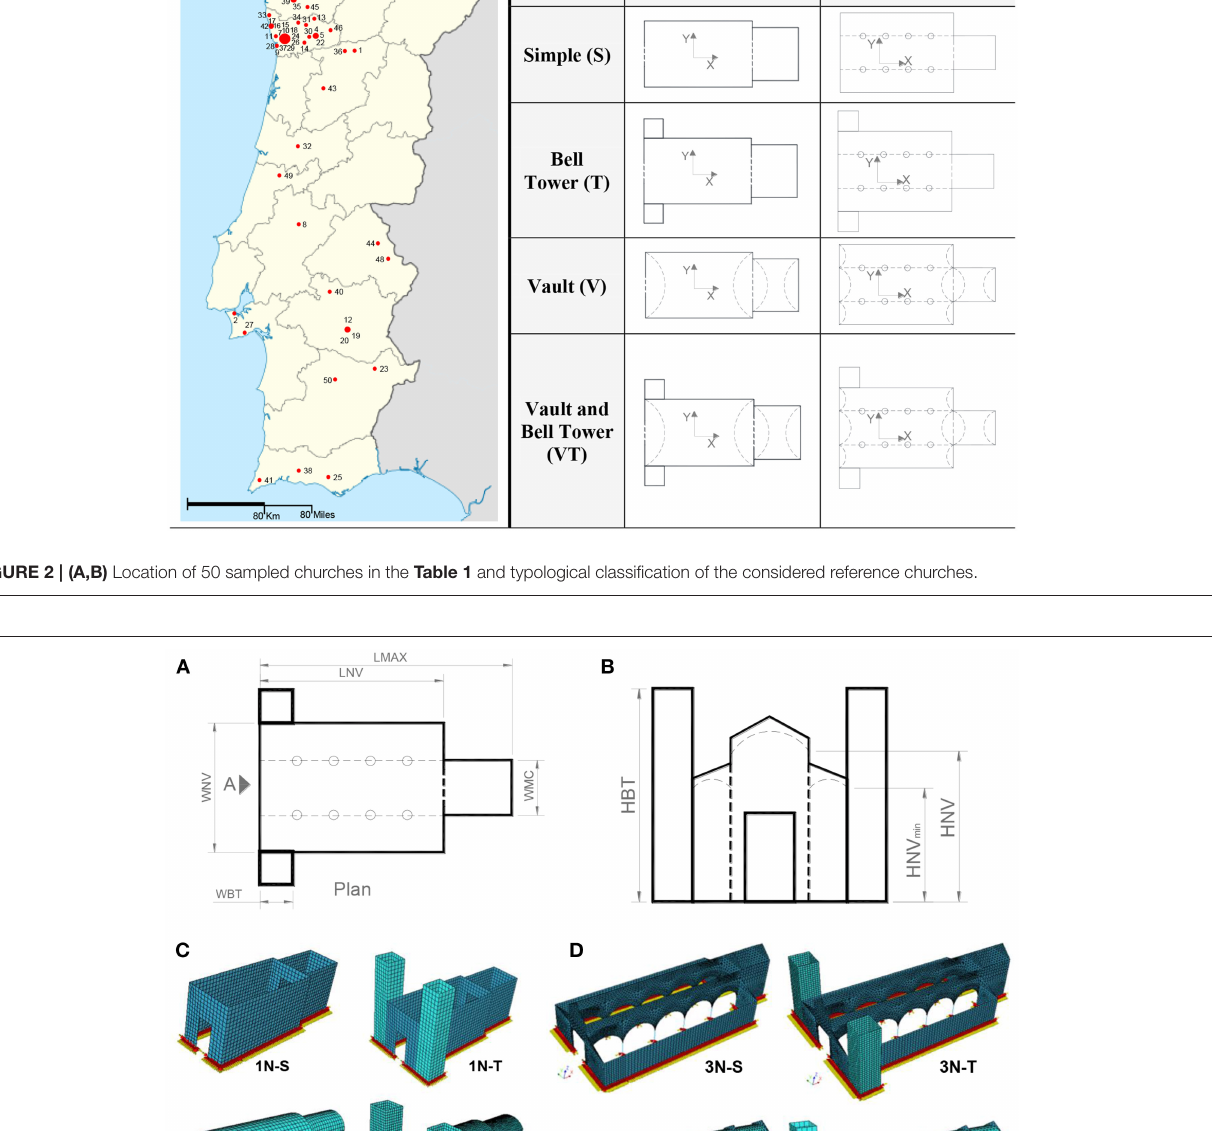
Frontiers in Built Environment |